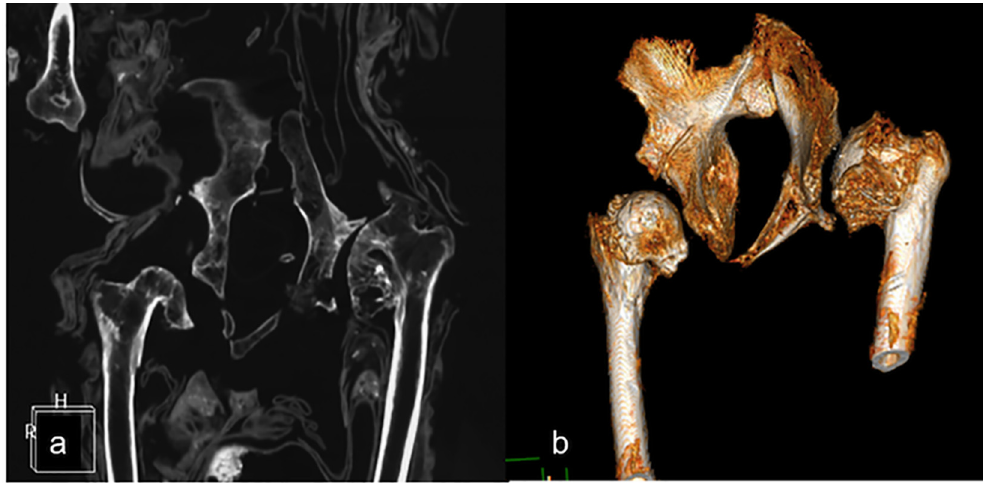
Fig 7. Severe deformation of femoral head related to dysplasia as shown in MPR coronal (a) and VR reconstructions